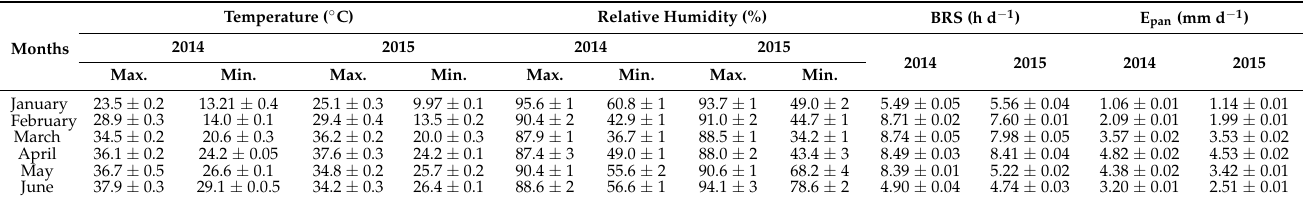
Table 1. Meteorological data during the